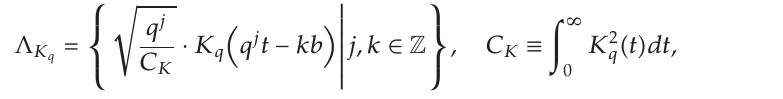
Figure 9: (cid:2) a (cid:3) Rogue 1520 from Draupner, January 1995; (cid:2) b (cid:3) relative magnitude of coe ffi cients for 3 scales { 1, q , q 2 } for q (cid:5) 1 . 5; (cid:2) c (cid:3) relative magnitude of coe ffi cients for 5 scales { q j } 4 using largest 30 coe ffi cients; (cid:2) e (cid:3) largest magnitude of comparison between Draupner data and